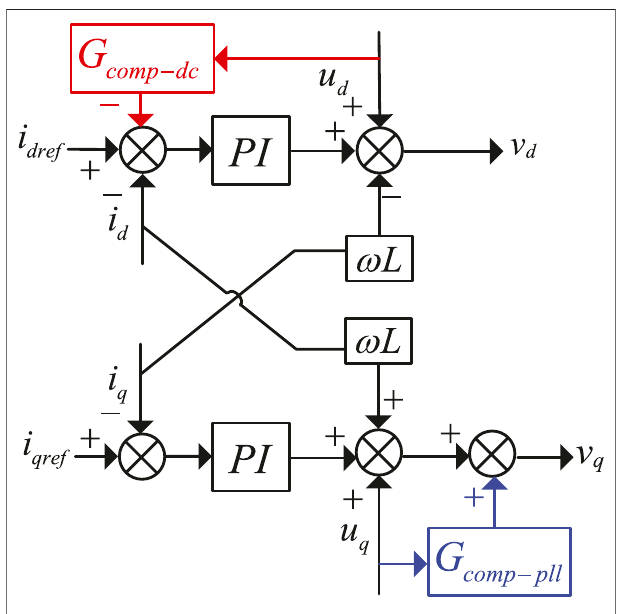
FIGURE 11 | Diagram of the current loop control system with compensation terms.